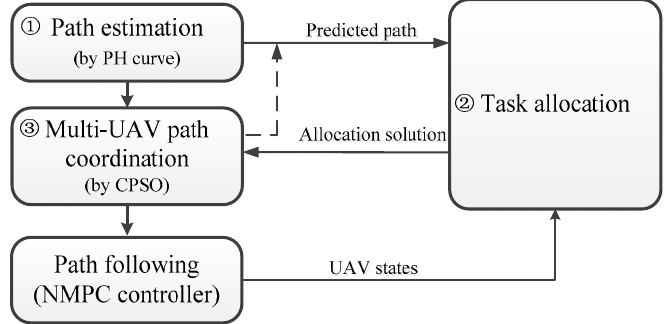
Figure 1. Integration framework of task allocation, path planning and path following.